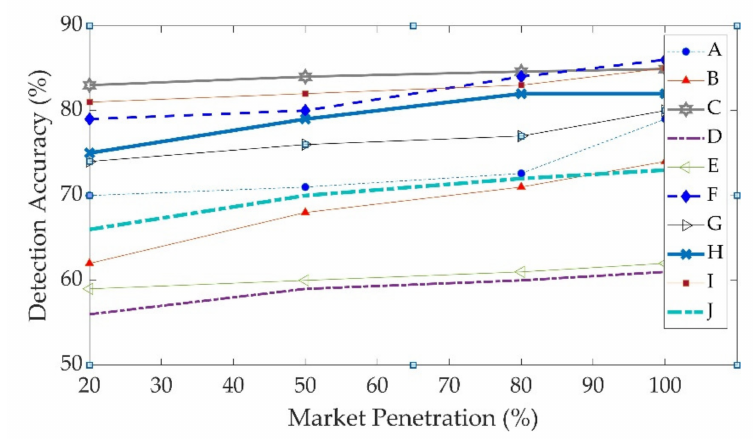
Figure 5. Relation between market penetration and DA for incidents A to I.